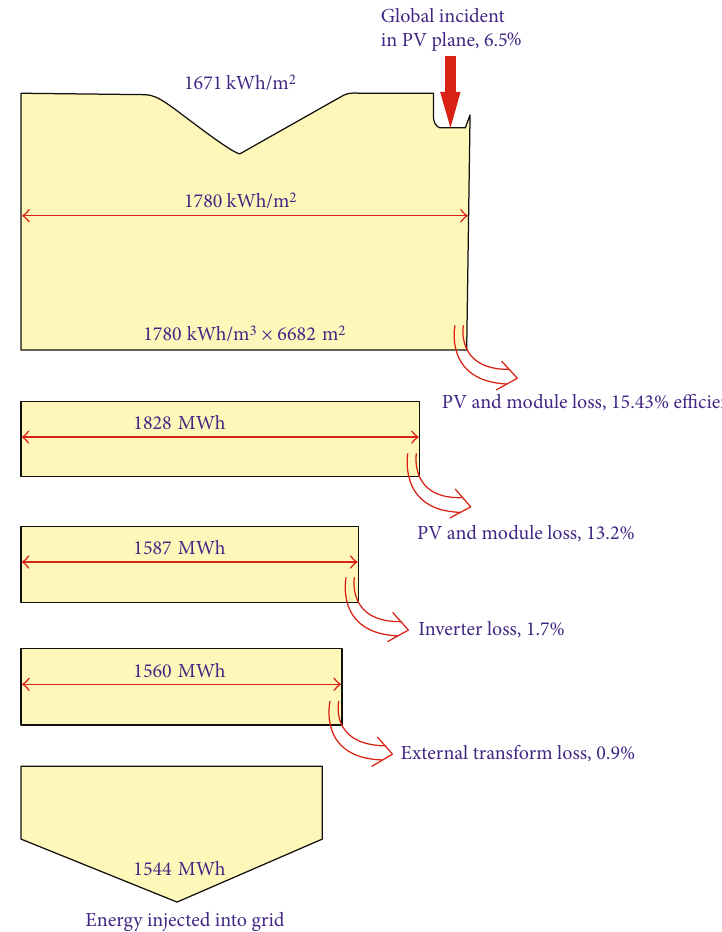
Figure 3: Electricity generation of a proposed solar PV system considering losses [24].